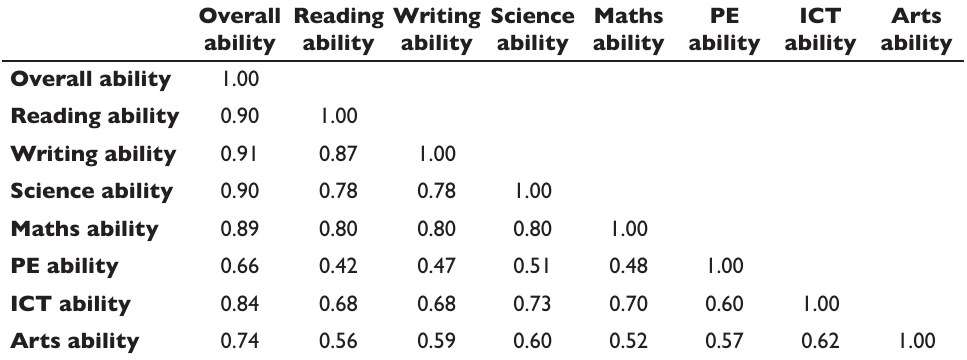
Table 1: Correlations between summed teacher judgement and judgements in each individual domain Overall ability